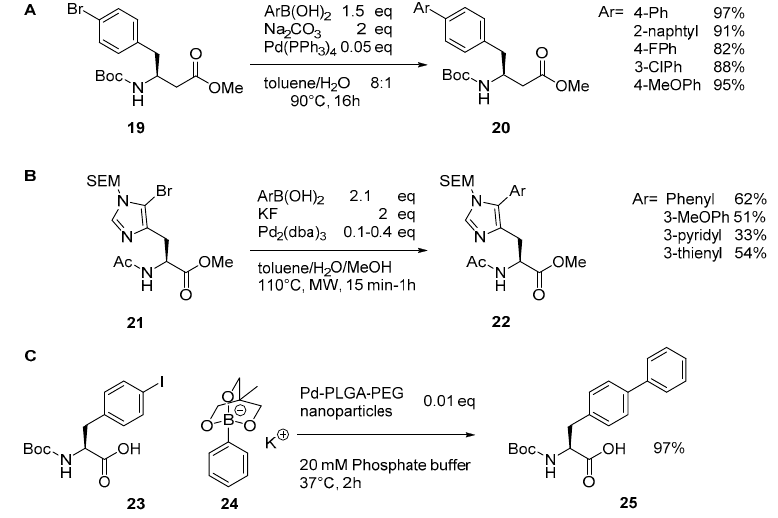
Figure 5. ( A ) Derivatization of β 3 -homophenylalanine 19 in mixed aqueous conditions. ( B ) Protected 5-bromohistidine 21 as a substrate for arylation. ( C ) Cross-coupling with palladium nanoparticles yielding 25 .